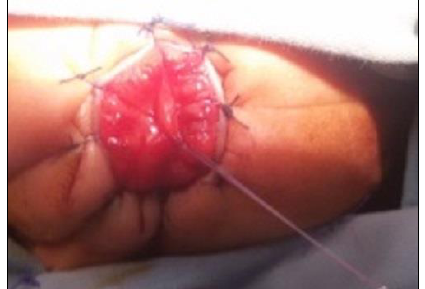
Figure 1: Intra operatively, an inner mucosal membrane was seen bulging.